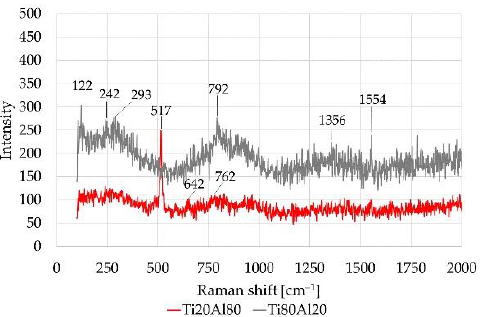
Figure 13. Raman shift for different Titanium areas in specimens Ti20 – AlSi and Ti80 – AlSi. Table 6. Raman shift measured for (a) corroded aluminium; (b) spongy-like aluminium; (c) Tita-